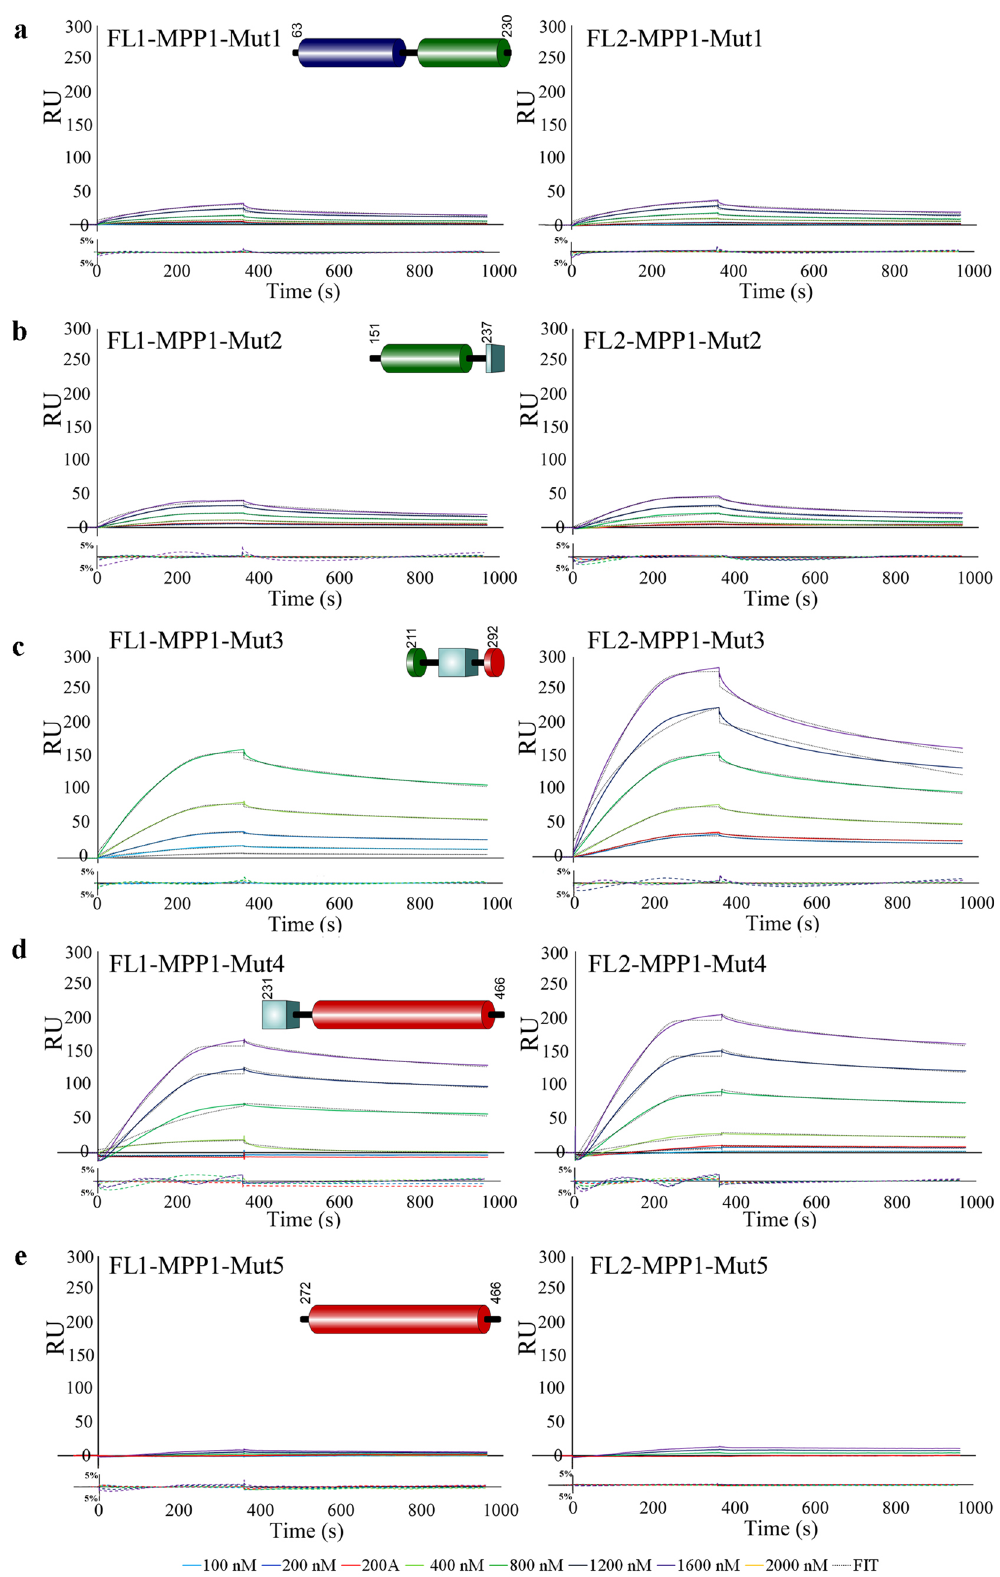
Figure 5. The D5 domain of MPP1 is of key importance for binding of flotillins. ( a – e ) HIS-tagged flotillins were immobilized on the Ni–NTA chip and their interactions with untagged MPP1 truncated mutants (MPP1- Mut1-5) in a series of concentrations 0–1600 nM were analyzed using a BIAcore T200. Other details as in Fig. 2